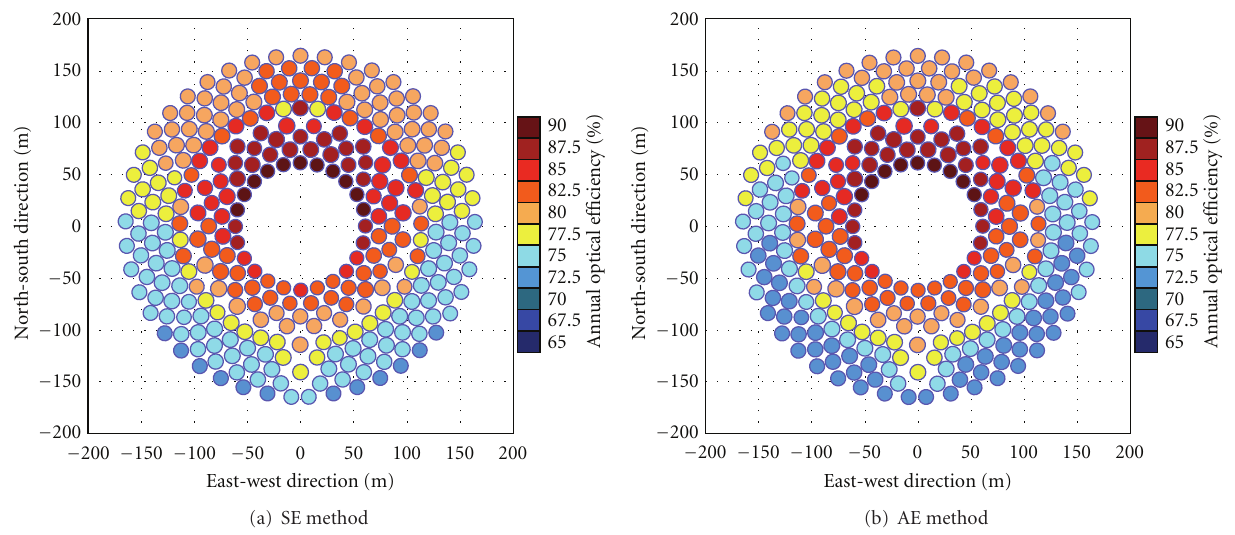
Figure 7: The annual optical e ffi ciency of heliostat in the case of latitude 15 ◦